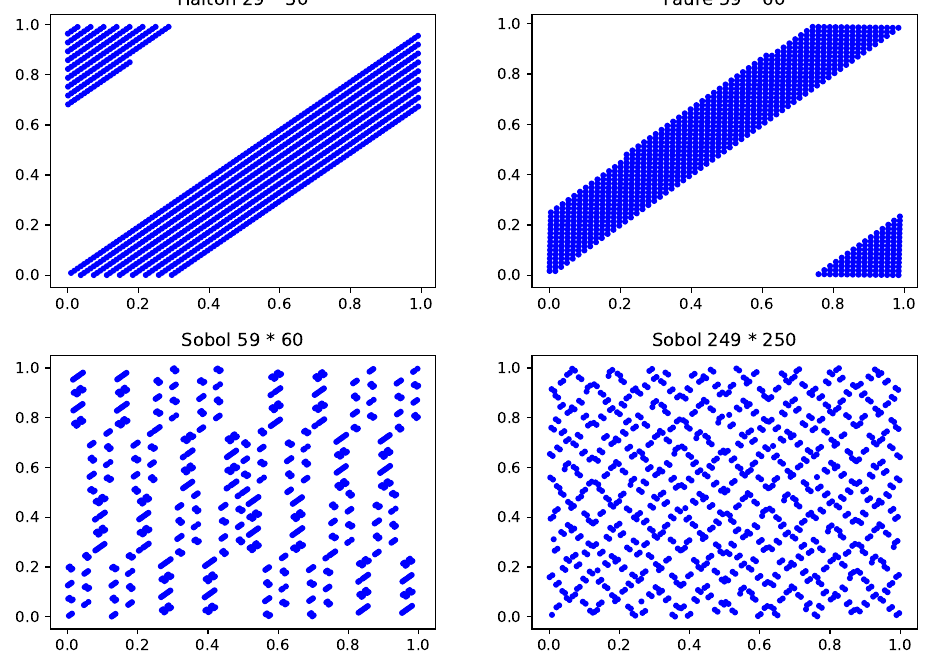
Figure 2. Two-dimensional distribution of adjacent low-discrepancy sequences (high-dimensional case). The Halton and Faure sequences show varying degrees of degeneracy, while the Sobol sequence still shows good